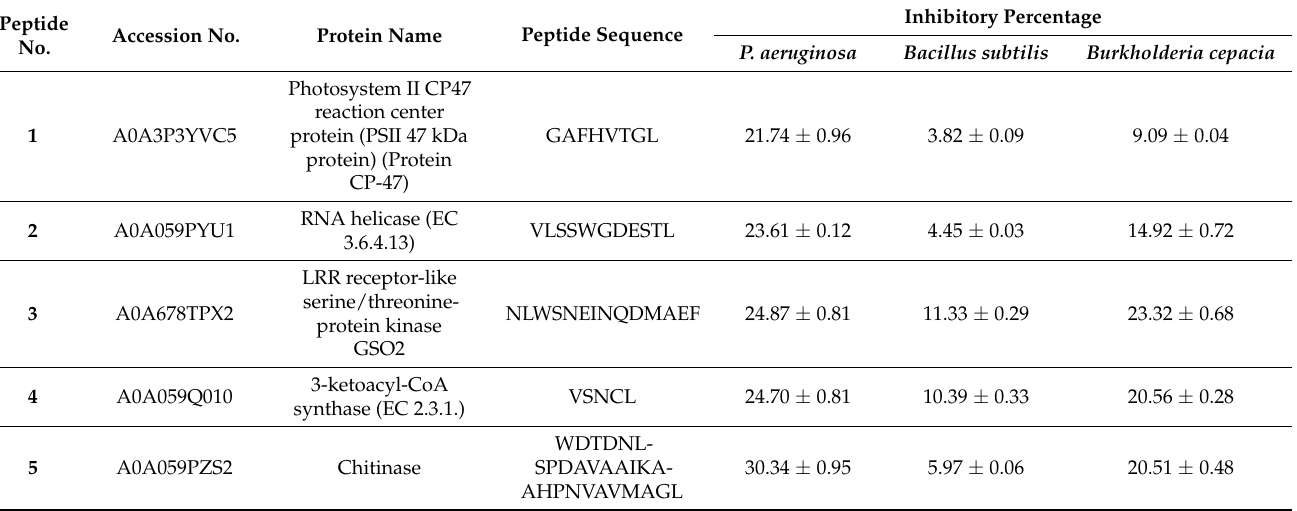
Table 2. Inhibitory percentages of synthetic peptides derived from peptide those purified from protein hydrolysates of bagasse